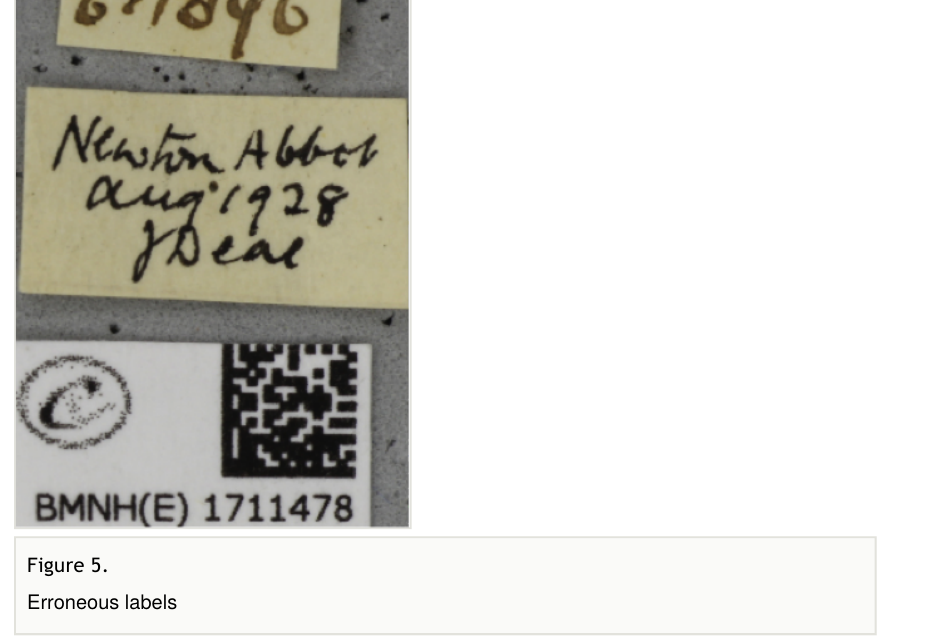
Figure 5. Erroneous labels